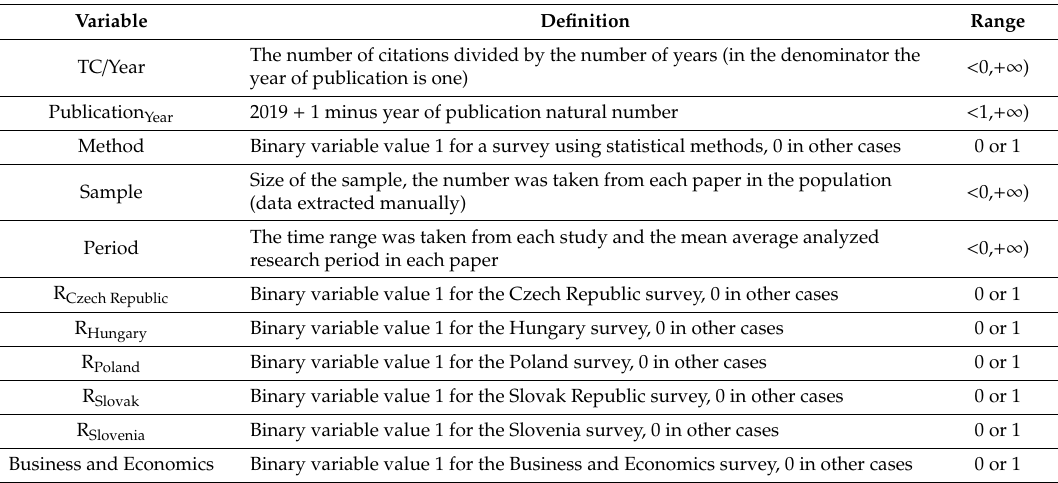
Table 2. The list of variables and their definitions.